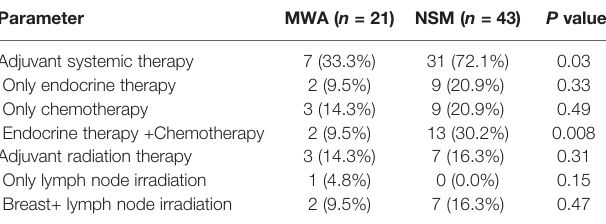
TABLE 1 | Baseline characteristics for patients in the study group. TABLE 2 | Adjuvant